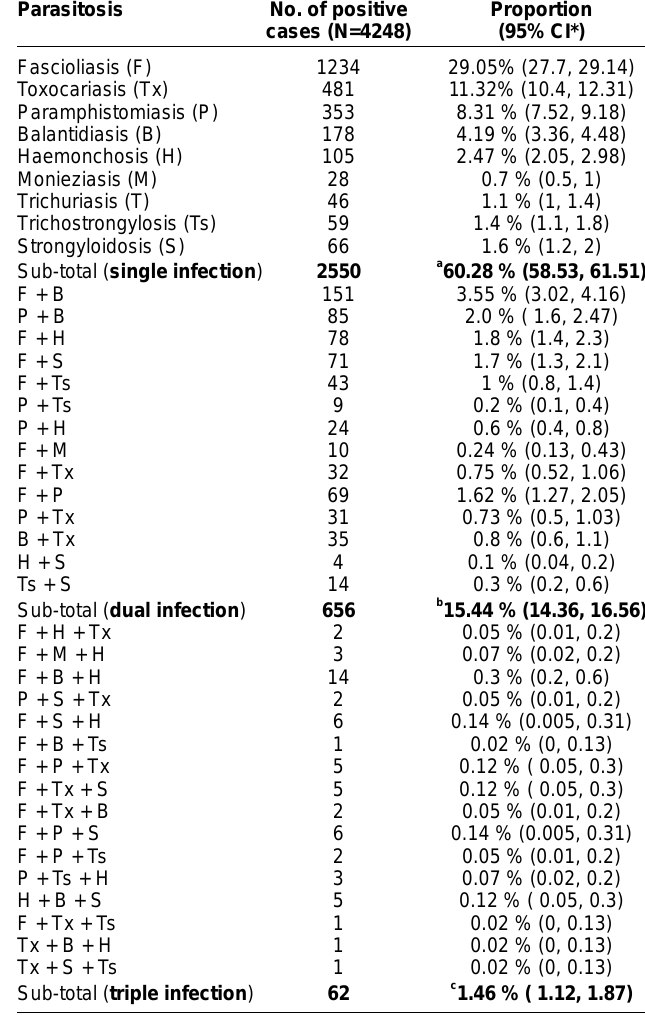
Table-1. Overall proportion of gastrointestinal parasitism in cross-bred cattle at